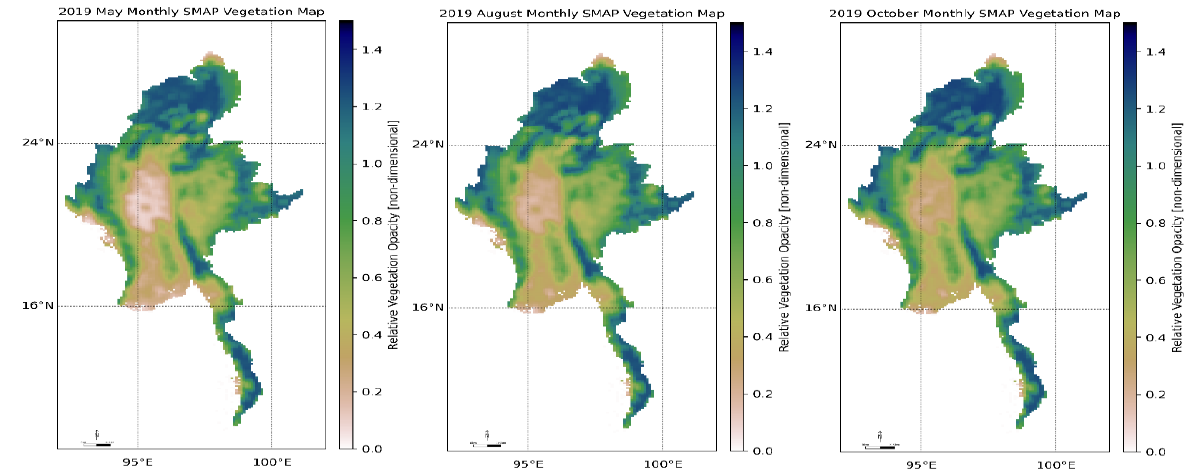
Figure 6. SMAP Radiometer vegetation opacity maps in May, August, and October 2019.